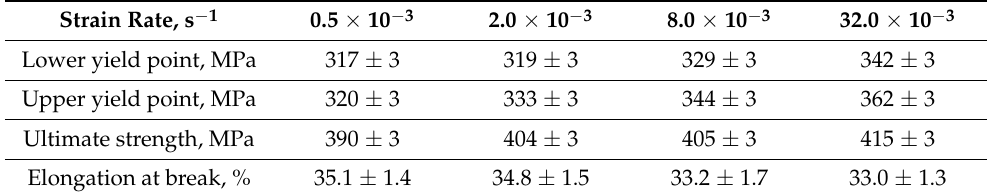
Figure 2. Stress – strain curves for variable strain rates. Table 2. Mechanical properties a function of strain rate obtained from 3 repetitive measurements.